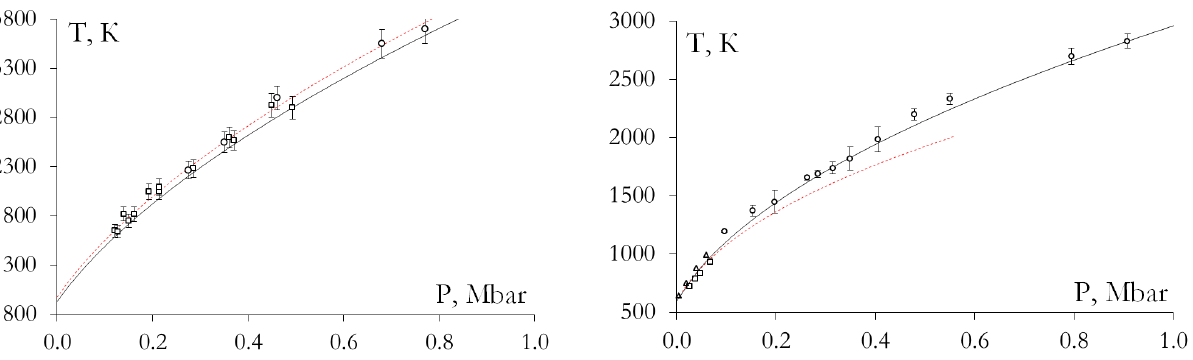
Figure 6: Melting curve for Al. The solid curve is the present calculation; the experimental data  and  [15, 16]. The dashed curve is Simon’s melting curve.